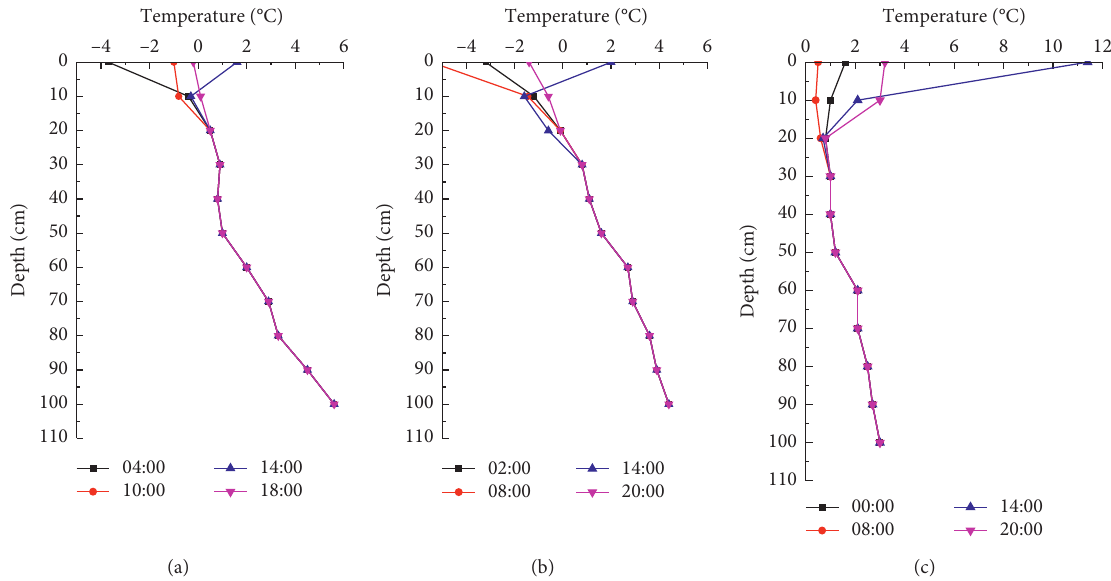
Figure 3: Daily variation of ground temperature with depth in Bin County. (a) December 10 th . (b) January 10 th . (c) March 10 th .